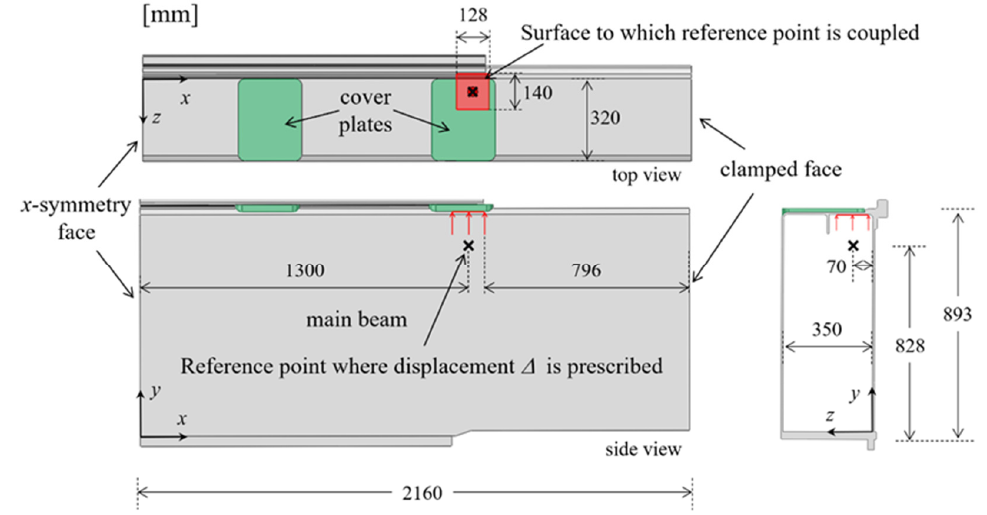
Figure 8. Overview of the beam structure showing top and side view of the component, with its symmetry yz-plane.